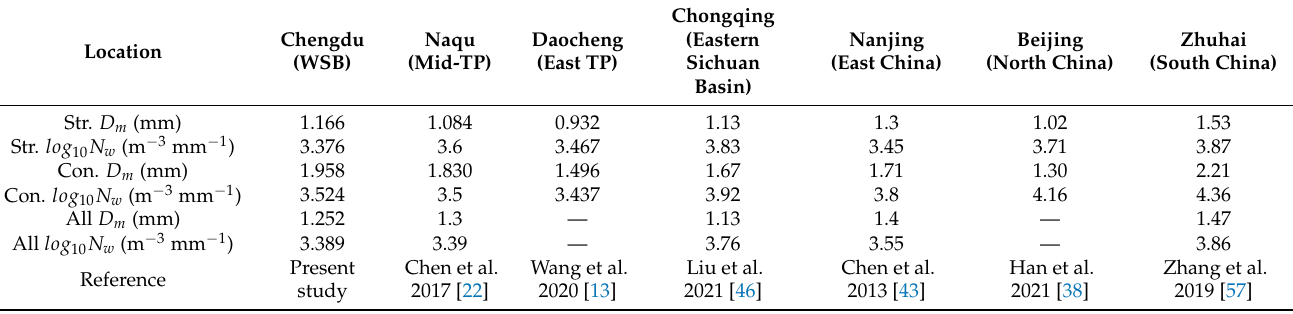
Table 2. Mean values of 𝐷 of China. The unit of 𝑁